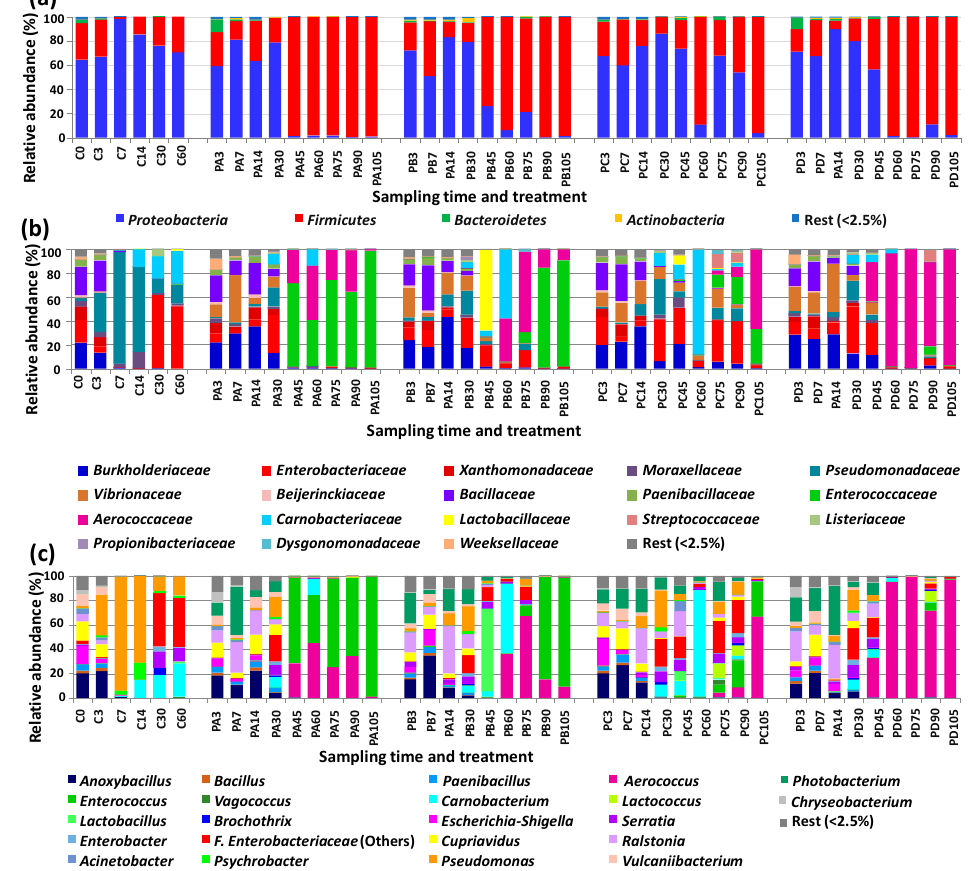
Figure 1. Relative abundances at the phylum ( a ), family ( b ), and genus ( c ) level of the main bacterial groups of cod samples corresponding to trial 2 at different storage times. C, controls. Treatments: PA (300 MPa, 8 min, 50 °C); PB (600 MPa, 4 min, 50 °C); PC (600 MPa, 8 min, 22 °C); PD (600 MPa, 8 min, 50 °C).